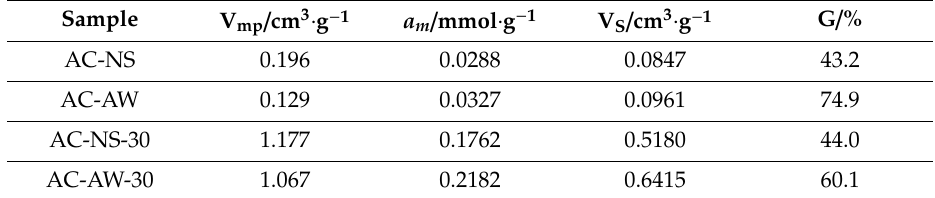
Table 2. The volume of pores occupied by molecules of vitamin B 12 ( V S ), and the degree of e ff ective usage of the mesopores ( G mp ) for the activated carbons AC-NS, AC-NS-30, AC-AW,